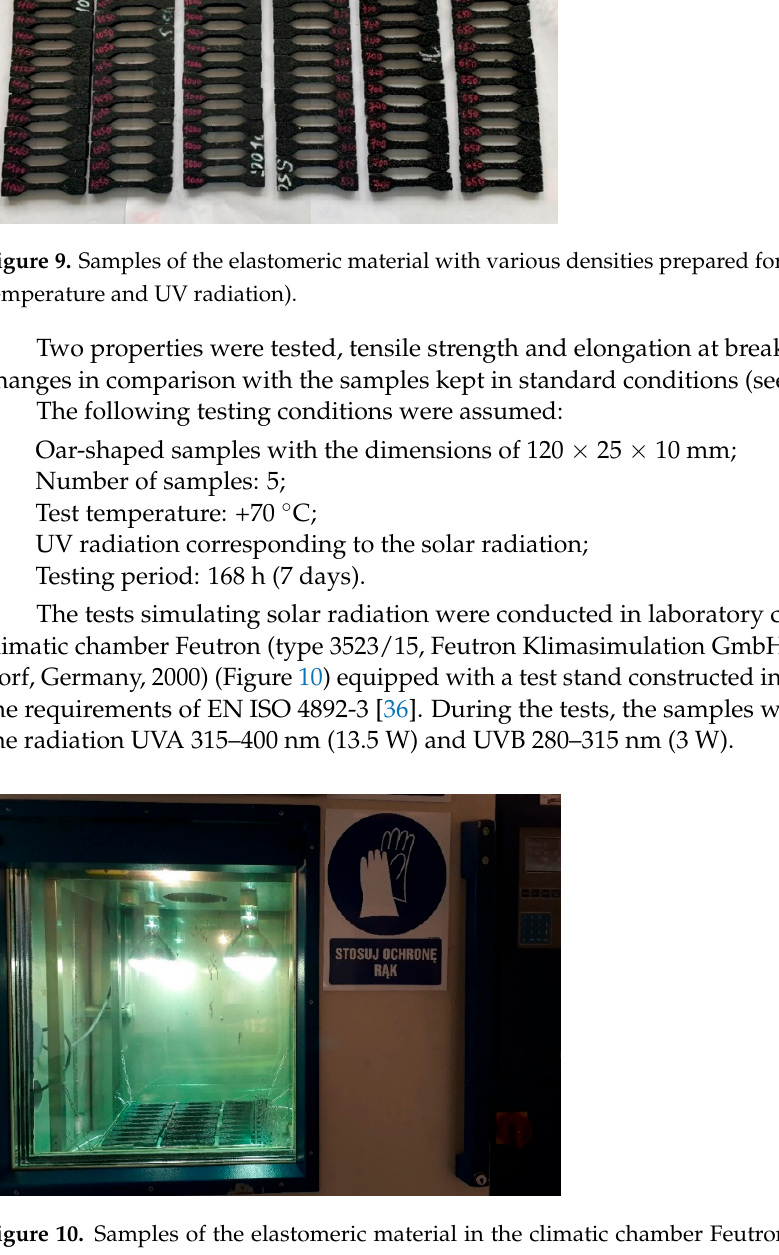
Figure 10. Samples of the elastomeric material in the climatic chamber Feutron, simulating high temperature and solar radiation.